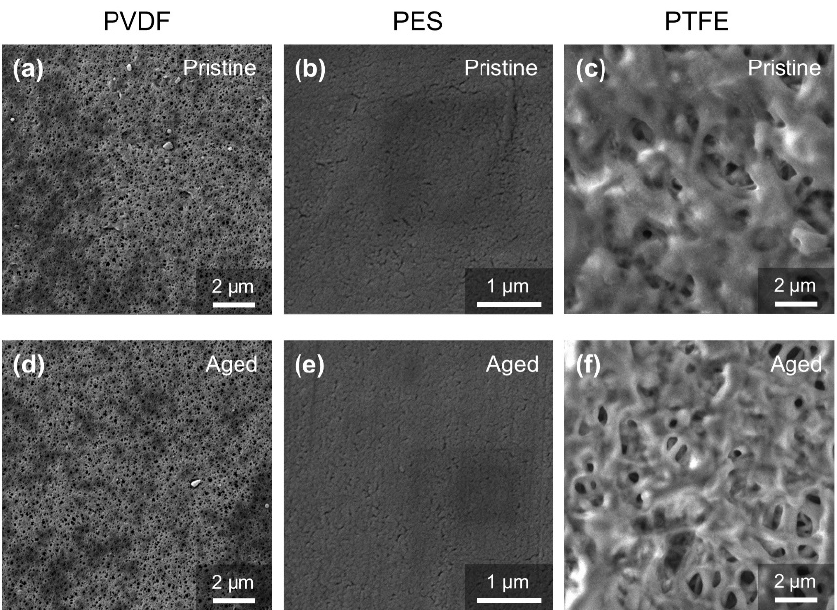
flow porometer as shown in Figure 2a, may be attributed to the loss of hydrophilicity.